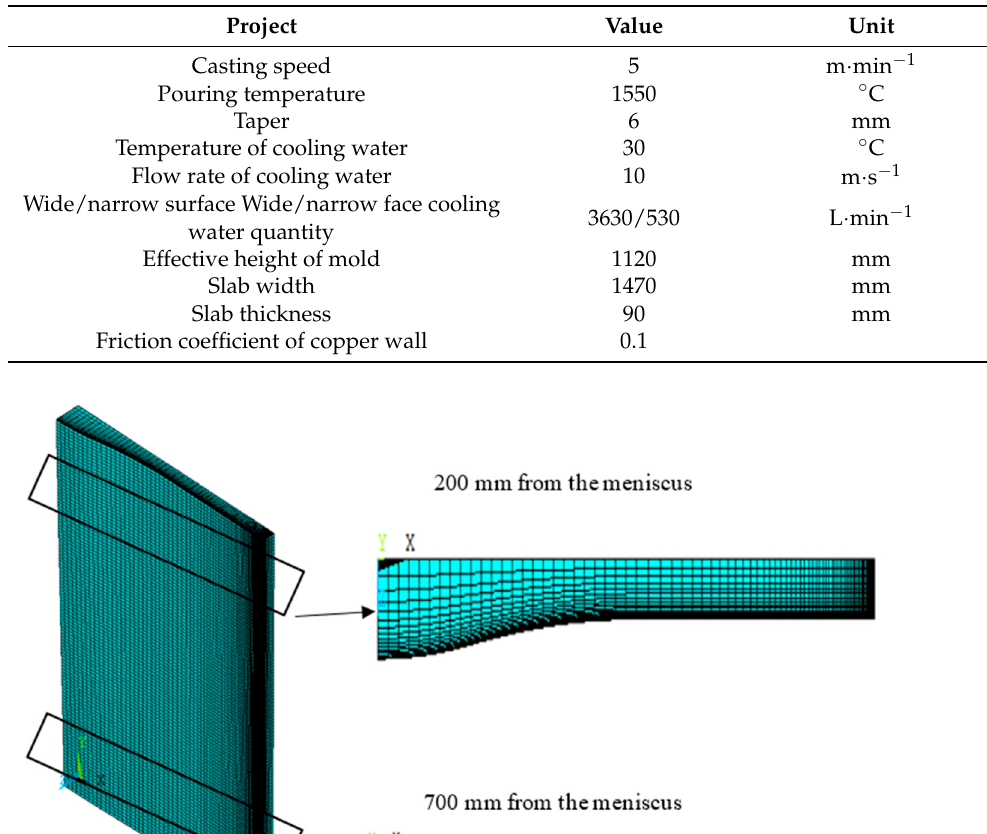
Table 1. Continuous casting process parameters.